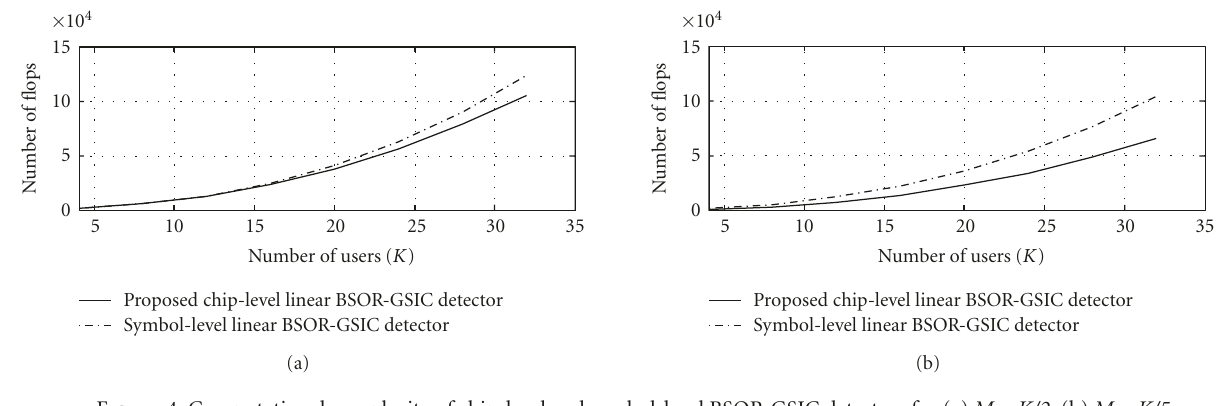
Figure 4: Computational complexity of chip-level and symbol-level BSOR-GSIC detectors for (a) M = K/2 , (b) M = K/5